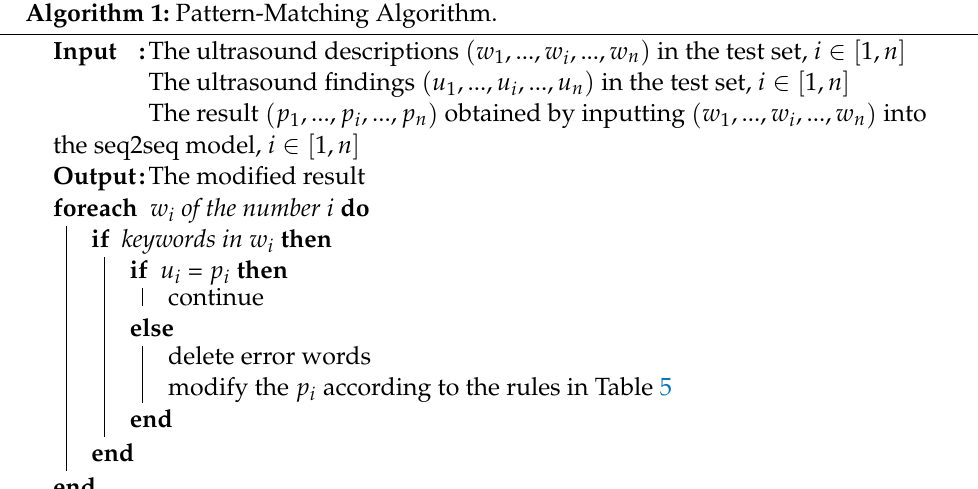
Algorithm 1: Pattern-Matching